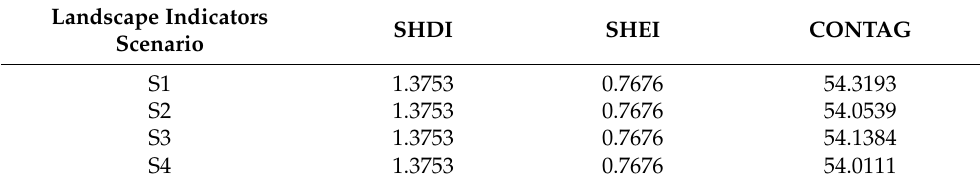
Table 6. Overall landscape metrics in 2035 under different